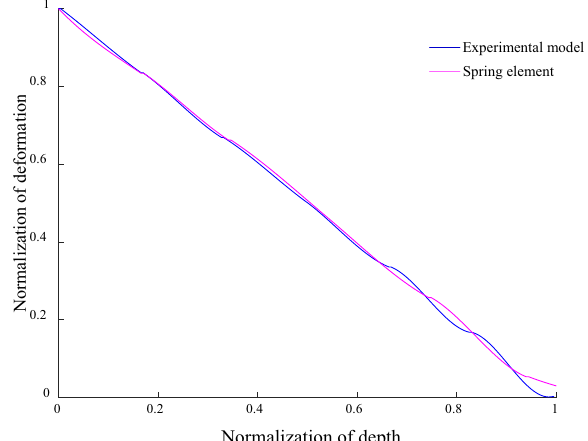
Figure 8. Guide rail deformation of spring element and experimental